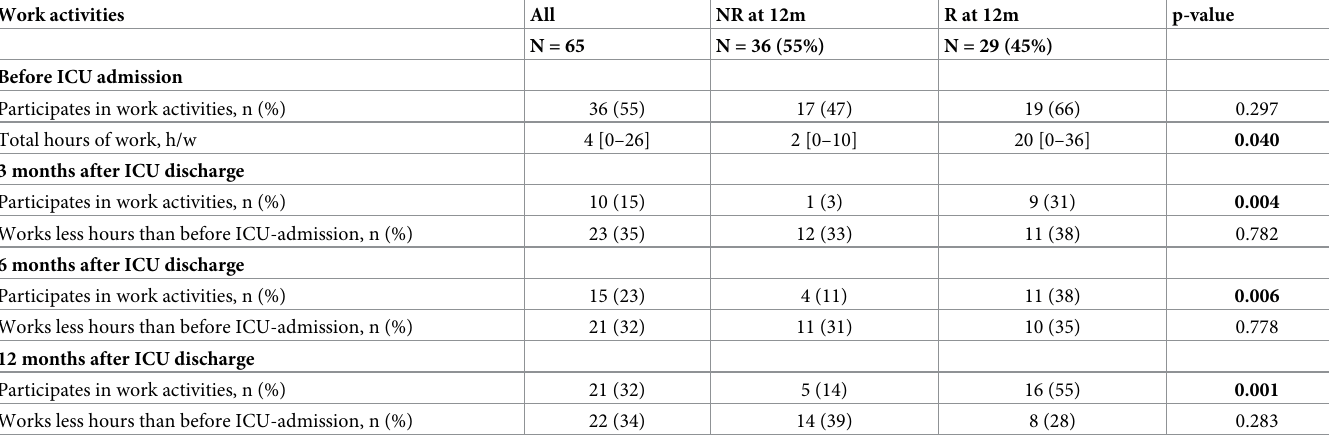
Table 3. Participation in paid and volunteer work activities and hours worked over the first year after ICU admission.